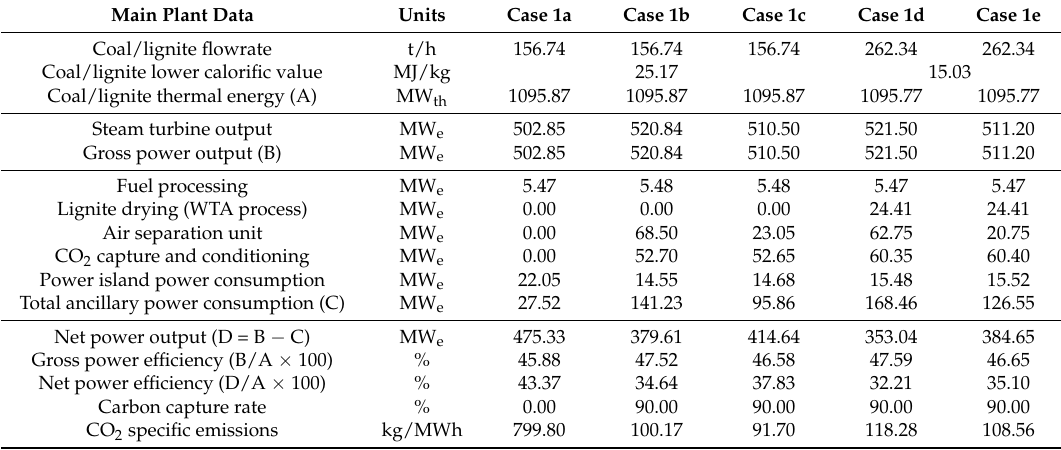
Table 2. Overall coal and lignite oxy-combustion power plant technical performances.